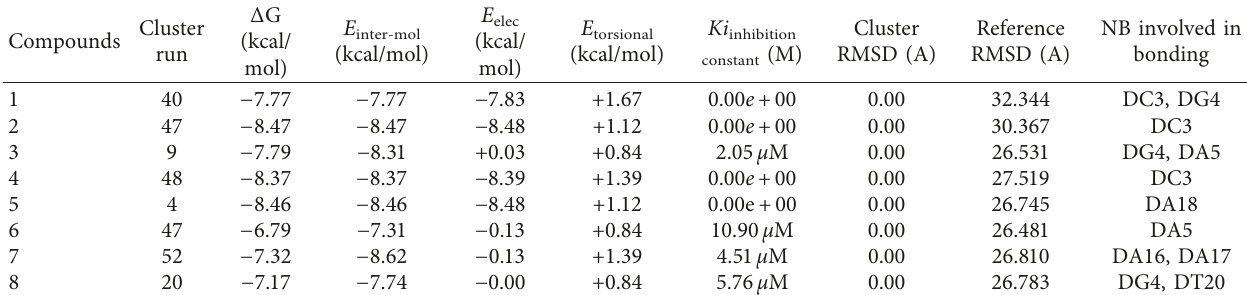
Figure 5: CD spectrum of Ct-DNA (5.5 × 10 − 5 M) in the absence and presence of heterocyclic Schiff base derivatives 3, 4, and 5 in 5 mM Tris buffer. Table 1: Molecular docking study of heterocyclic Schiff base derivatives ( 1 – 8